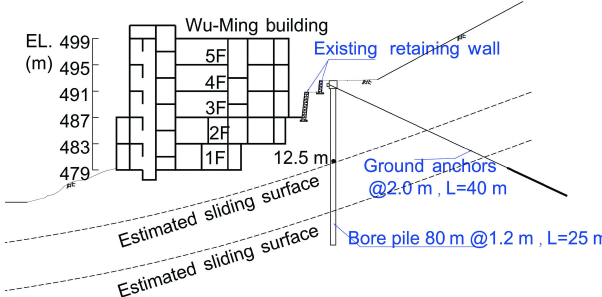
Figure 21. Strengthening construction for the Wu-Ming building (B2) via bored piles with tieback anchors.